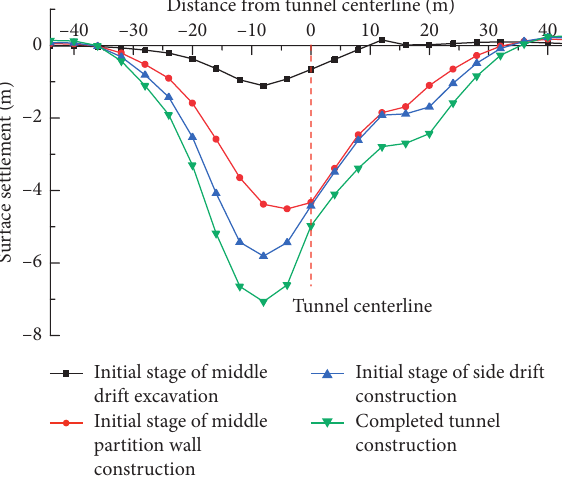
Figure 14: Surface settlement